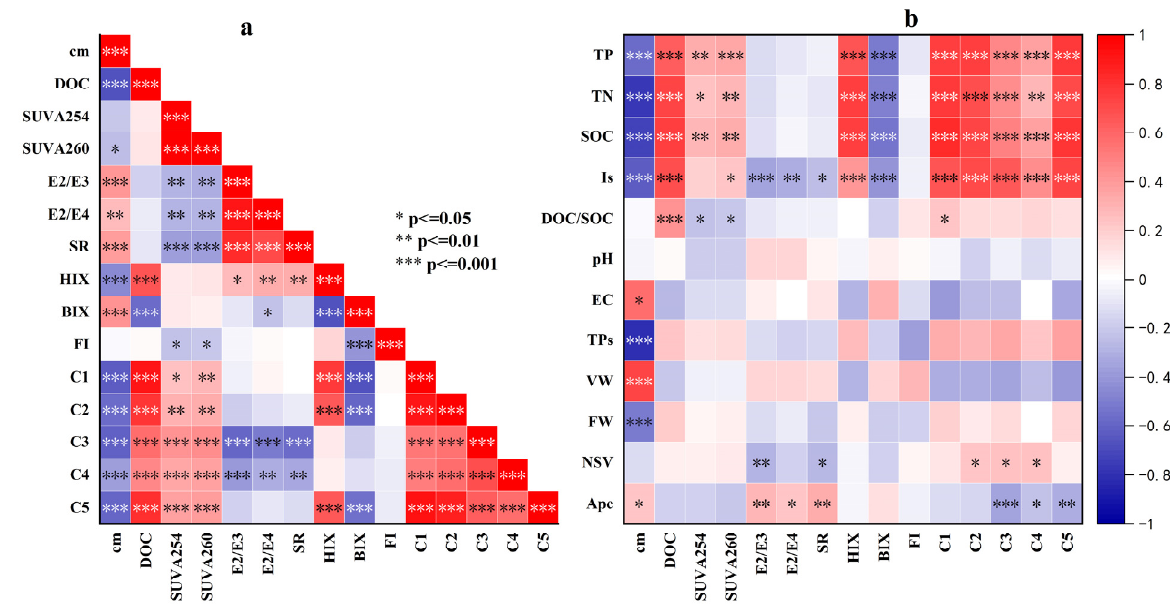
Figure 6. Pearson correlation coefficients between DOM parameters ( a ) and environment ( b ) for fissured soil.